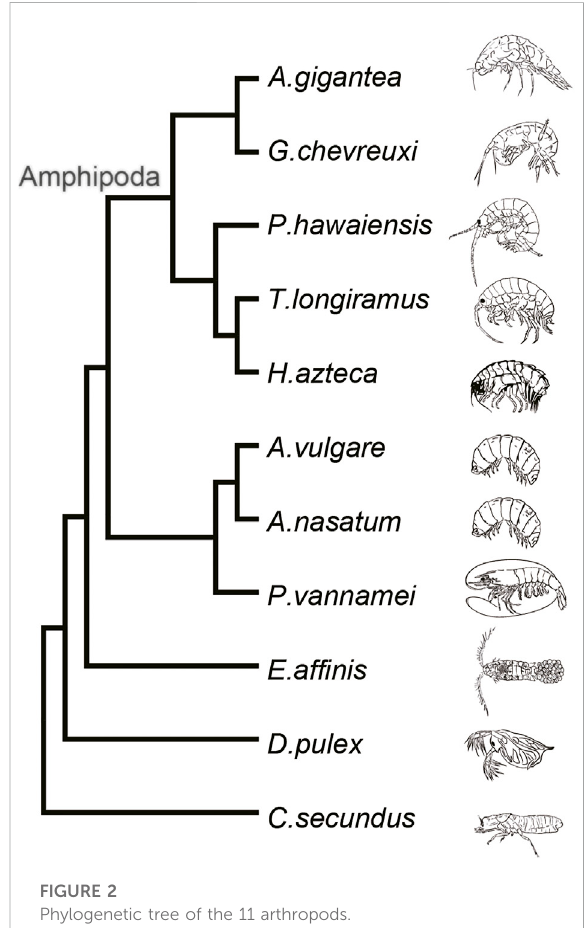
FIGURE 2 Phylogenetic tree of the 11